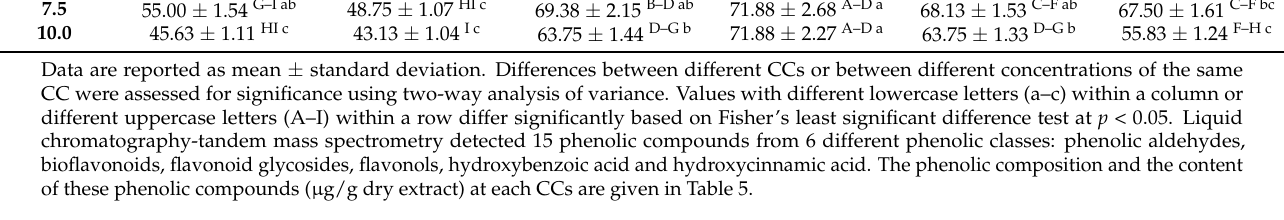
Table 1. Allelopathic effect of different concentrations of aqueous extracts of cover crops on A. artemisiifolia germination. Extract Concentra- All Crops Mixed tion (CCMIX) ( w / v )